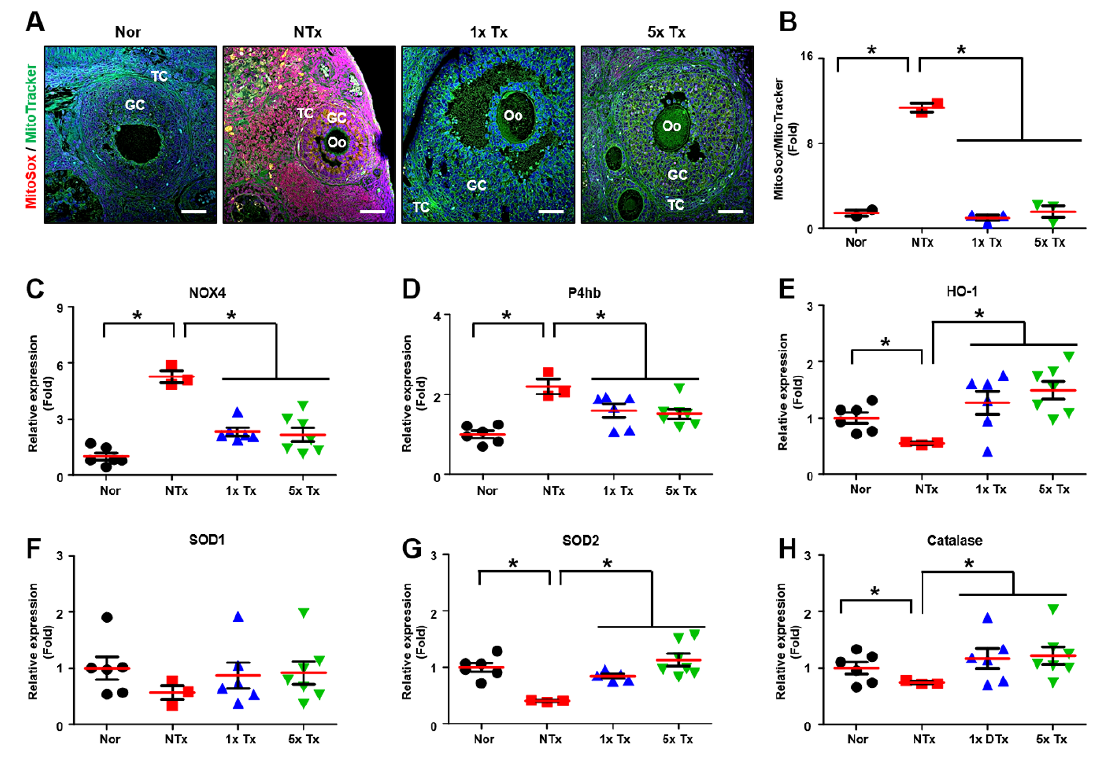
Figure 3. Effect of a low dose of PD-MSCs on oxidative stress in the ovaries of rats with ovarian dysfunction. ( A ) The ovarian tissues of TAA-injured rats were stained with MitoSOX and mitoTracker. Scale bar: 20 µ m, Magnification: 20 × . ( B ) The intensity of MitoSOX/MitoTracker was quantified by means of the Image J program. ( C ) The mRNA expression levels of NOX4 , ( D ) P4hb , ( E ) HO-1 , ( F ) SOD1 , ( G ) SOD2 and ( H ) catalase were analyzed by qRT-PCR. GC: granulosa cell, TC: theca cell, Oo: oocyte. The data are representative of three independent experiments and expressed as the mean ± S.D. Statistical significance was determined by using one-way ANOVA, * p <